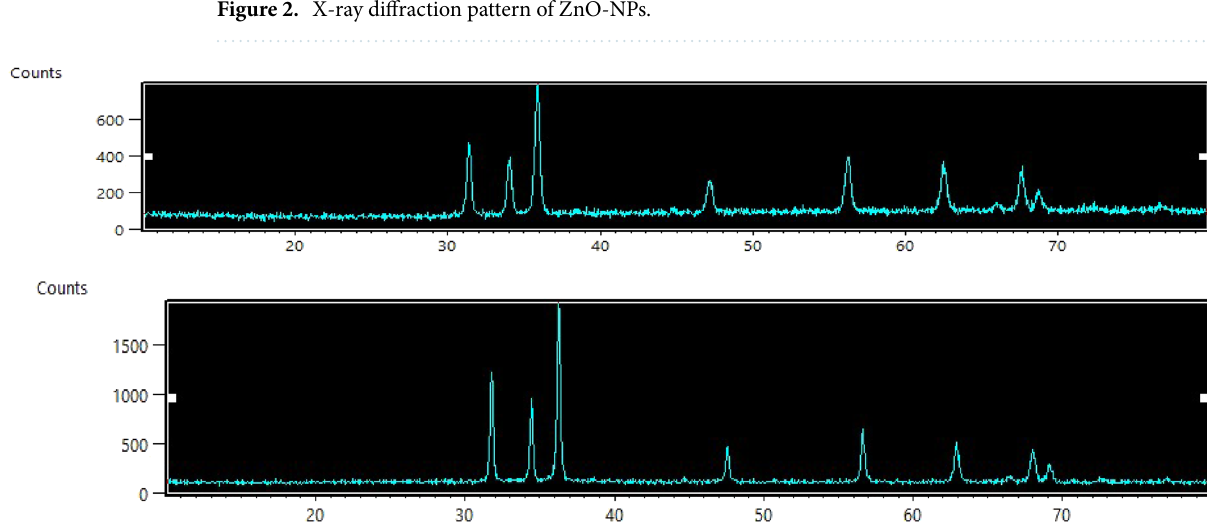
Figure 3. X-ray diffraction pattern of ZnO-NPs.